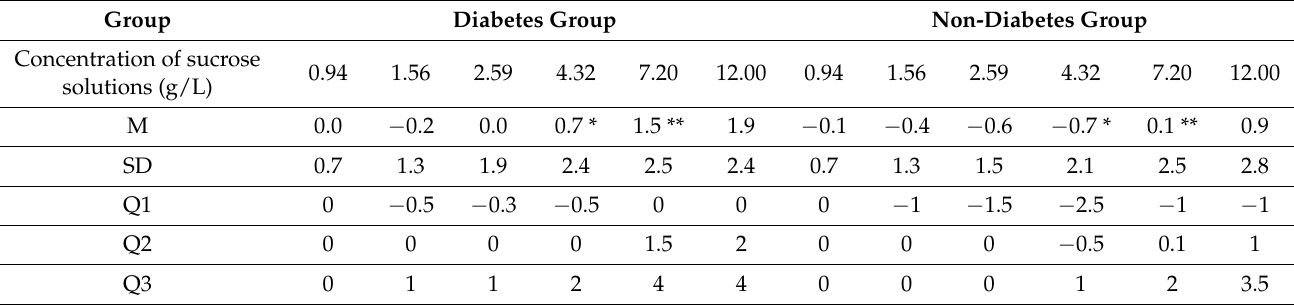
Table 8. Hedonic assessment of sucrose solutions by group.